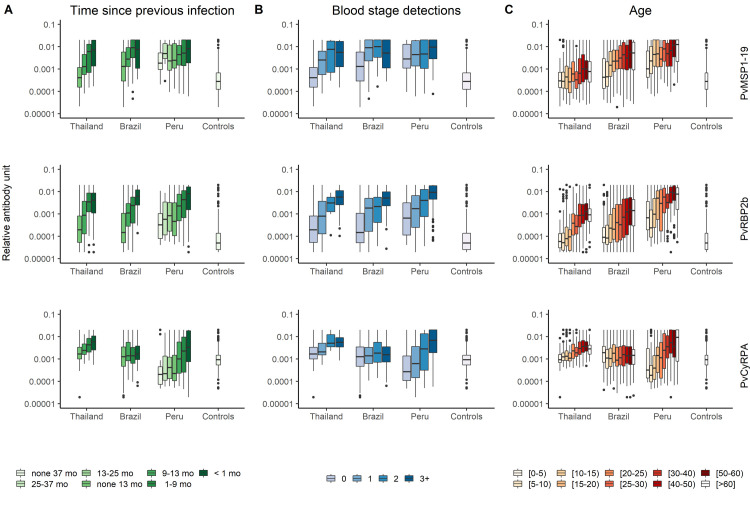
Association of antibody responses to PvMSP119, PvRBP2b and PvCyRPA with epidemiological features.(A) Antibody titers and time since previous infection during follow up. (B) Antibody titers and number of blood stage infections detected by qPCR. (C) Antibody titers across age groups. Note the controls are grouped together regardless of age. Mo: number of months since previous infection.